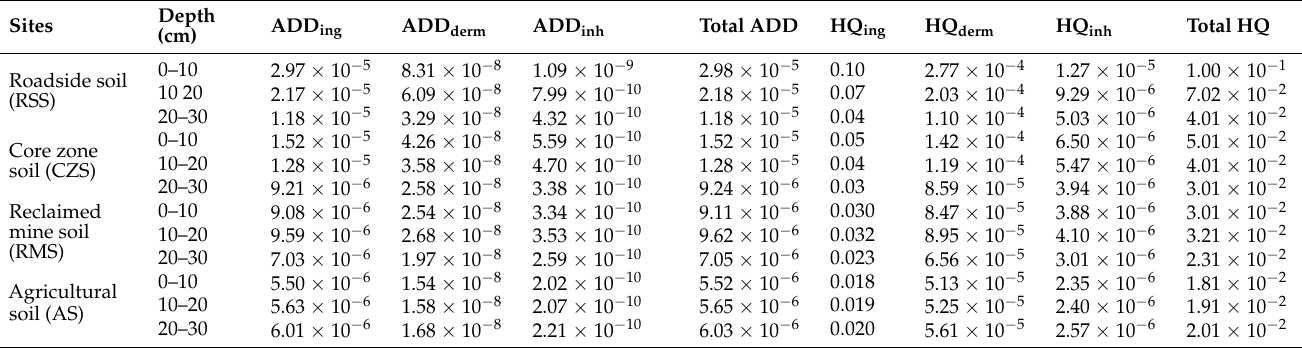
Table 3. Average daily dose (ADD) and hazard quotient (HQ) of Hg in three soil profiles